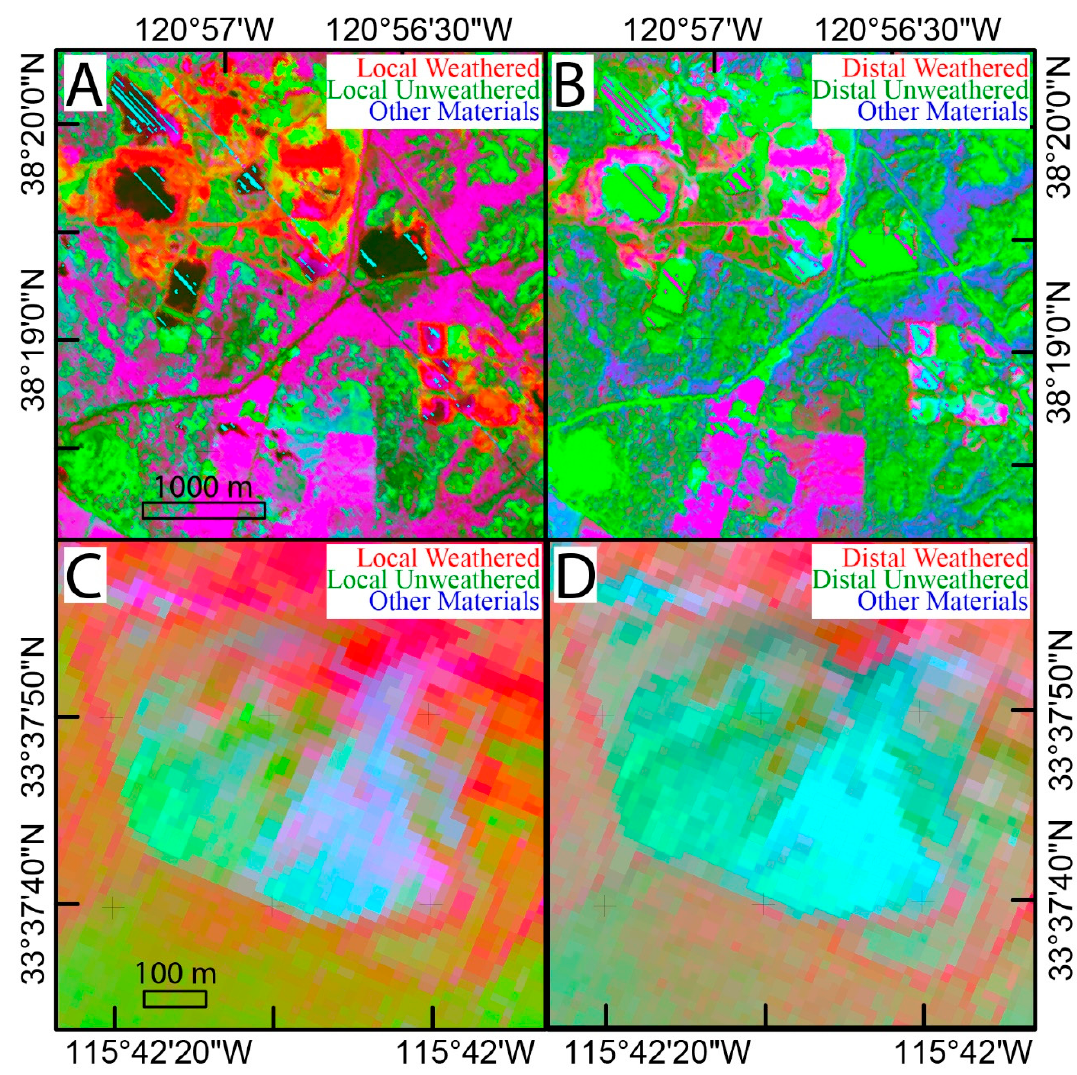
Figure 6. Cross-site comparison matrix. Top Row: Ione AVIRIS unmixed using local Ione ( A ) and distal Maniobra ( B ) endmembers. Bottom Row: Maniobra AVIRIS unmixed using local Maniobra ( C ) and distal Ione ( D ) endmembers. Although spatial patterns are clearly more informative using local endmembers in each case, the similarity in result when local and distal endmembers are used in both cases supports the inference similar geologic history across BTN outcrops spanning nearly 1000 km.